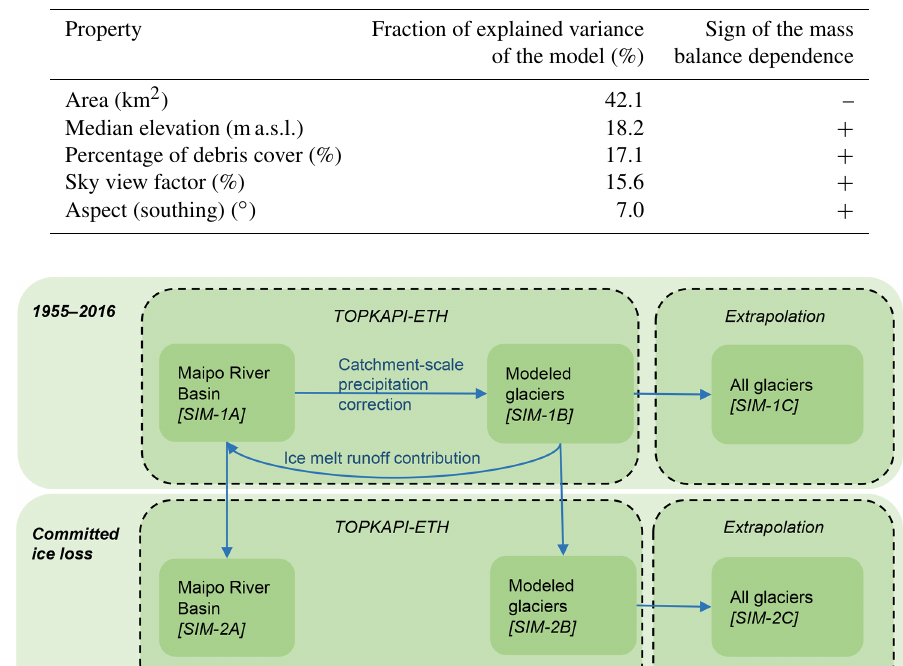
Table 3. Results of the multiple regression analysis for the committed ice loss scenario simulations.